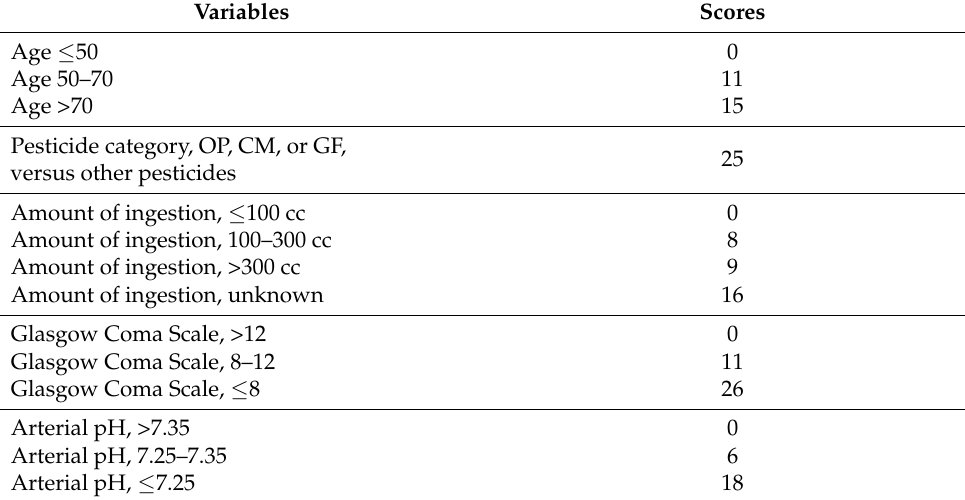
Table 3. Prediction of Respiratory failure in Pesticide intoxication (PREP) in patients with acute pesticide intoxication using scoring